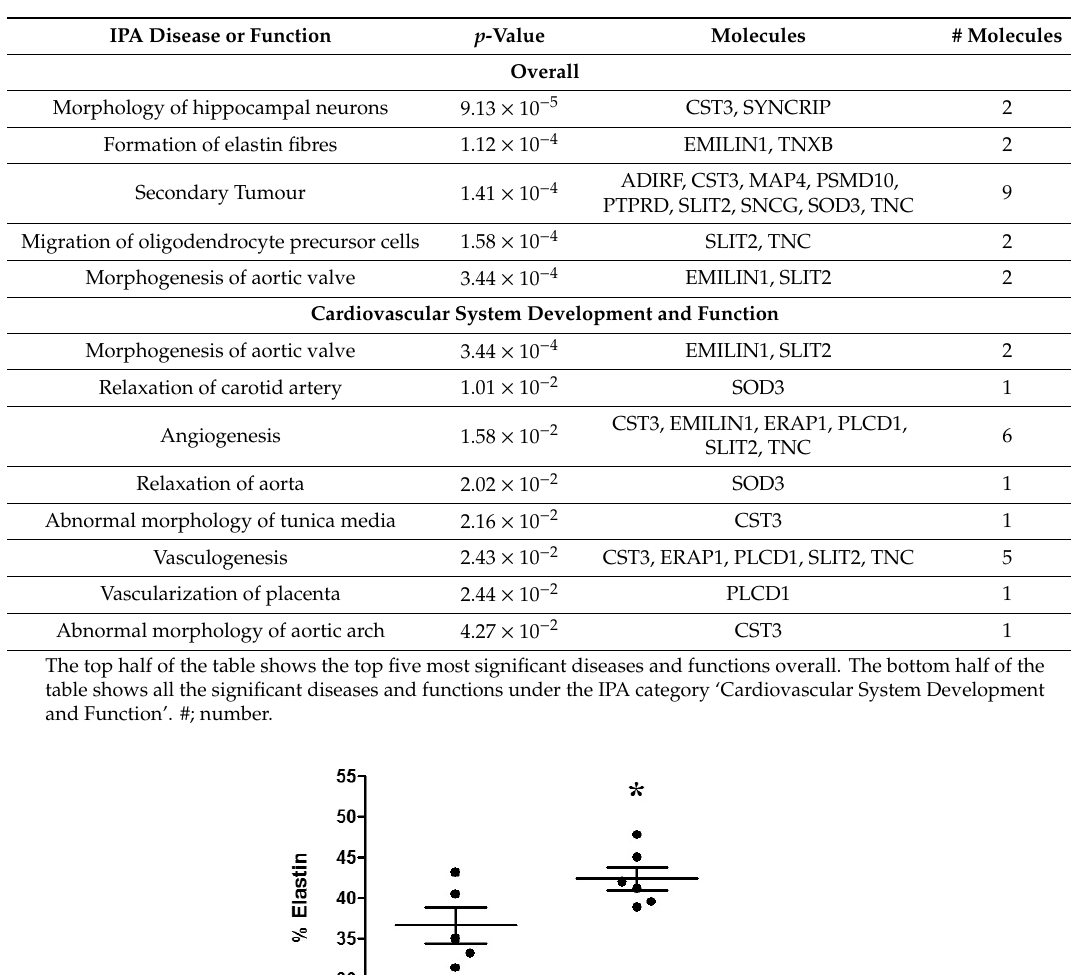
Table 3. Diseases and functions with enriched protein expression for significantly altered total protein levels in aortic tissue of BAV patients compared to TAV patients.